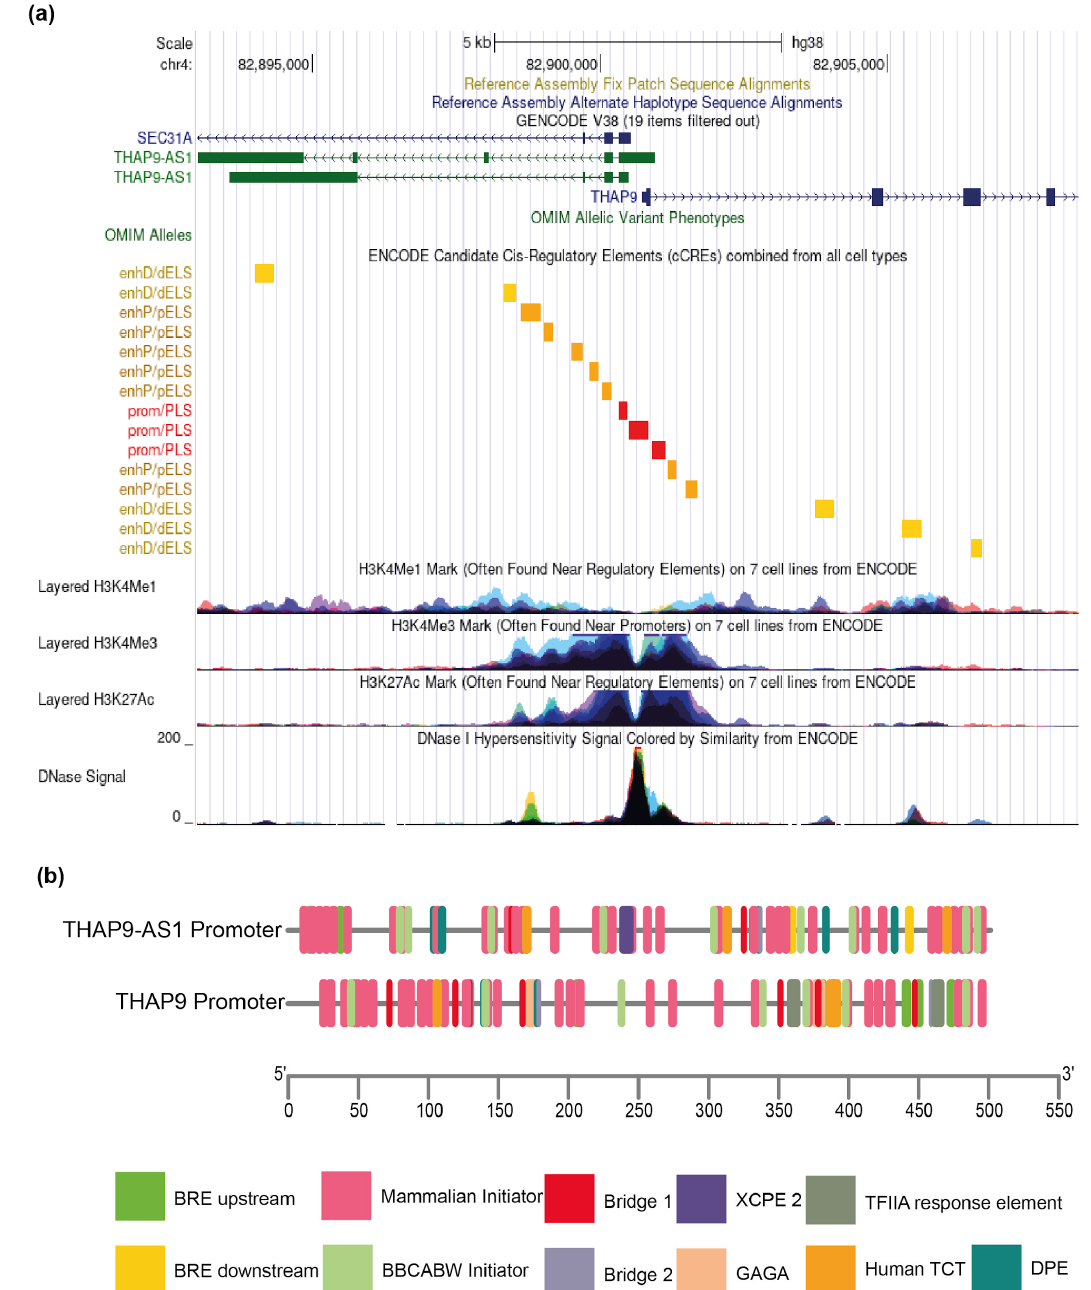
Figure 2. Characterization of THAP9/THAP9-AS1 putative bidirectional promoter region. ( a ) UCSC genome browser representing ENCODE data for THAP9/THAP9-AS1 bidirectional promoter region. The genomic region contains the putative bidirectional promoter region of the THAP9/THAP9-AS1 gene pair. The GENCODE genes track shows transcript variants for both genes. Below that is the ENCODE candidate cis-regulatory elements (cCREs) track, which shows the presence of several regulatory elements in the promoter region. The next three tracks are from ENCODE showing the H3K4Me1, H3K4Me3 and H3K27Ac marks followed by the DNAse I hypersensitivity signal shown in the last track ( b ) Schematic representation of the core promoter elements predicted by ElemeNT. The core promoter sequence used was − 250 to +250 relative to the TSS of THAP9 and − 400 to +100 for THAP9-AS1 (considering 82900569 as TSS) from EPDnew. The diagram is roughly to scale and was constructed using TBtools [43].